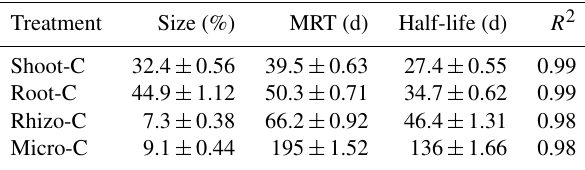
Table 2. Bioavailable labelled substrate C pool, mean residence time (MRT), and half-life of cumulative 13 C recovery in CO 2 and CH 4 of soils incubated with one of four labelled C